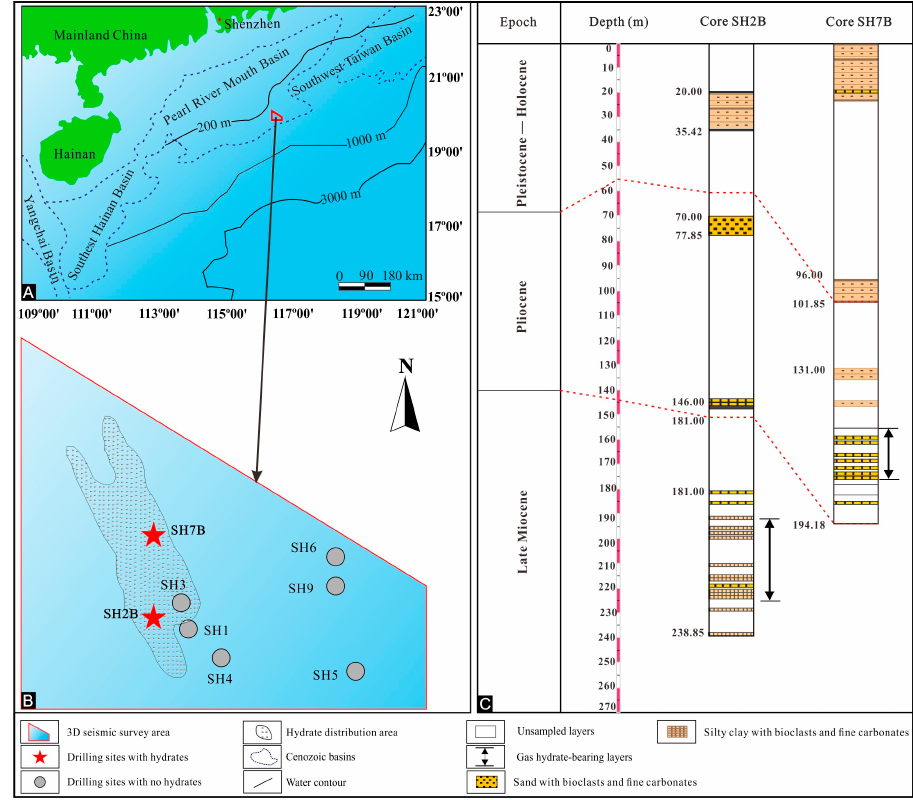
Figure 1. Maps illustrating the locations of sediment cores SH2B and SH7B ( A , B ) and stratigraphic columns ( C ) in the Shenhu area, the South China Sea (modified from references [9] and [24]).